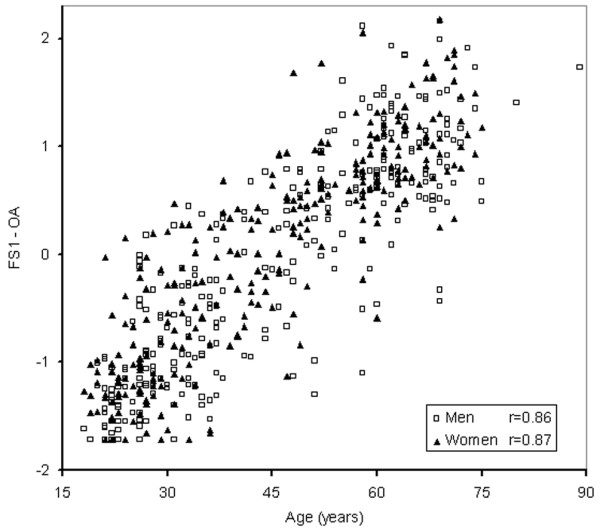
Age-dependence of osteoarthritis of the hand in men and women in the Chuvashian population sample. FS1-OA is the first factor score obtained from the principal component analysis of OA (osteoarthritis). The regression coefficients were calculated using the statistical package FISHER [25].